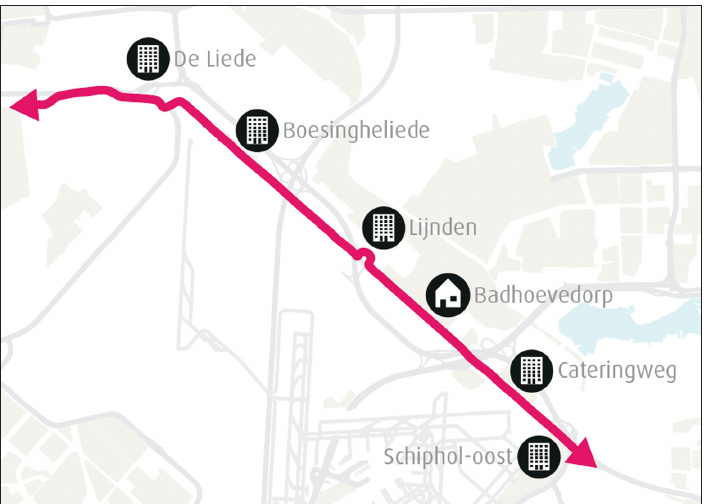
Figure 4: Main part of commuting route—five “patches” (Provincie Noord-Holland,